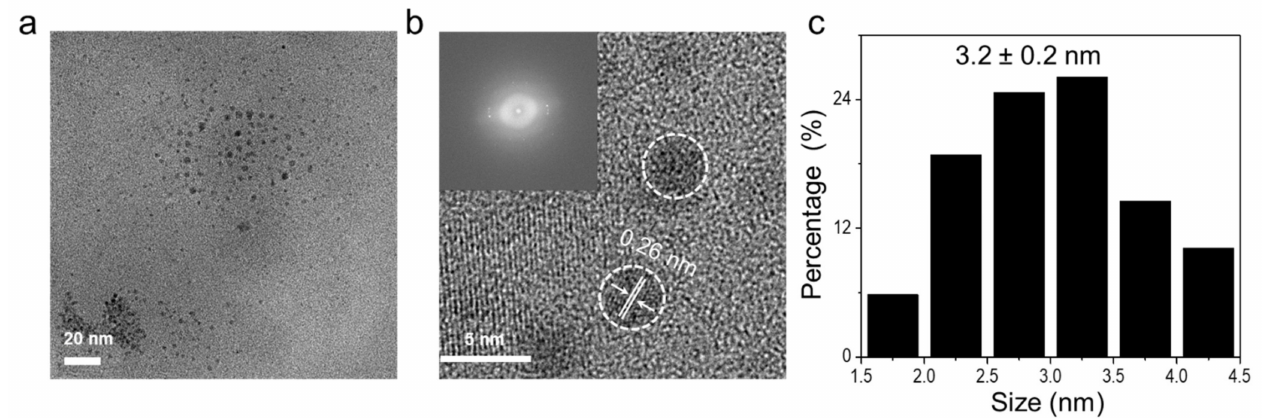
Figure 4. HR–TEM images ( a ) low, ( b ) high magnification, inset FFT image and ( c ) size distribution curve of the synthesized Ti 2 N